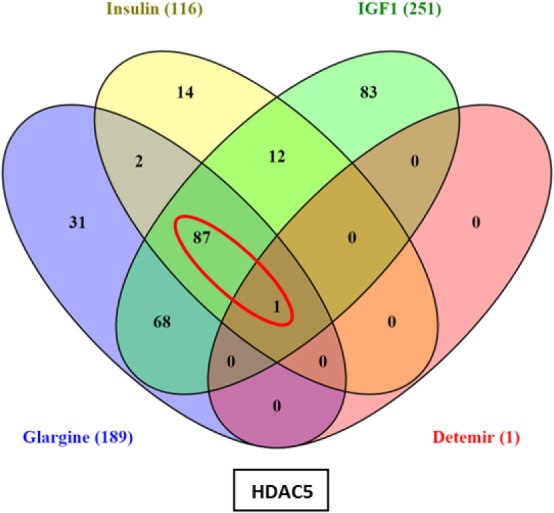
Venn diagram: differentially expressed genes in ECC-1 cells after ligands treatment. The diagram displays all possible logical relations between the differential gene expression sets for each treatment in ECC-1 cells. Only one gene (HDAC5) was differentially expressed after detemir treatment (shown in box). FC = 1.5 and pFDR < 0.05.